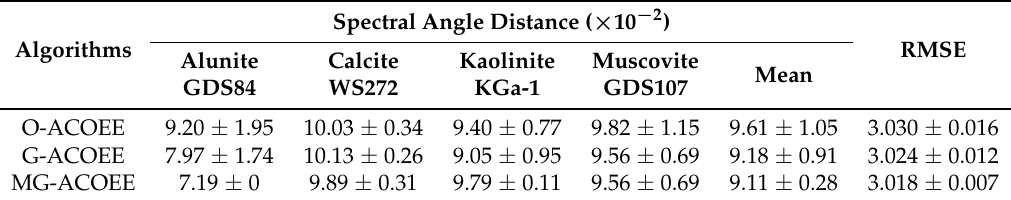
Table 2. Comparison of original (O)-ACOEE, G-ACOEE, and MG-ACOEE (abundance sum-to-one constraint (ASC)) on endmember extraction accuracy for Cuprite